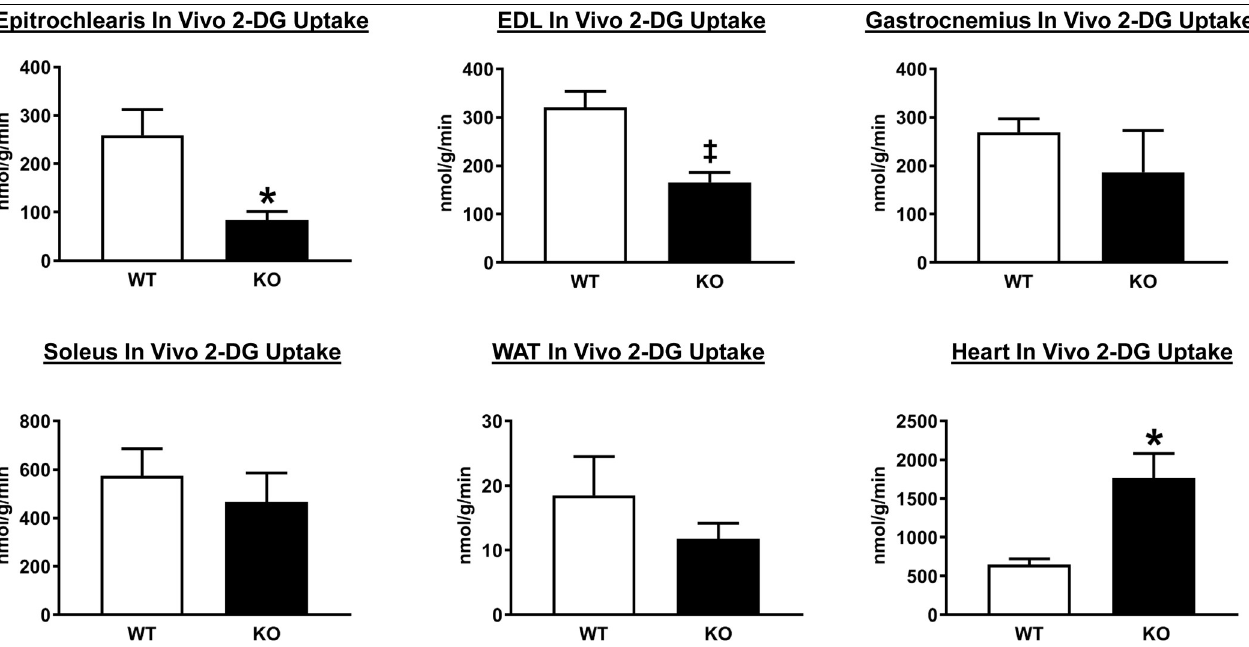
Fig 3. Tissue 2-deoxyglucose (2-DG) uptake in wildtype (WT; white bars) and AS160-KO (KO; black bars) rats subjected to the HEC. Extensor digitorum longus = EDL. White adipose tissue = WAT. Data were analyzed by Student’s t-test. � P < 0.05, ‡ P < 0.01 for WT versus KO rats. Means ± SEM for 4 rats of each genotype.